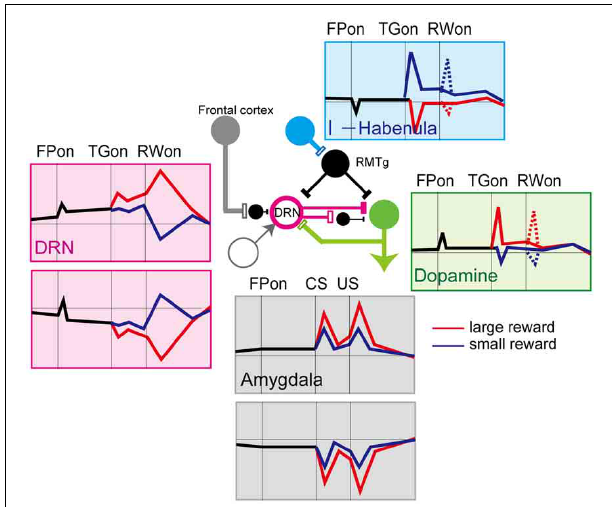
FIGURE 5 | Schematics of the activity of neurons in the different brain regions that project to the DRN. Red lines, large reward, blue lines, small reward. Activity for the biased-reward saccade task in dopamine (Kawagoe et al., 2004), lateral habenula (Matsumoto and Hikosaka, 2007, 2009), and DRN neurons (Nakamura et al., 2008), and for the Pavlovian conditioning task in the amygdala (Belova et al., 2007, 2008) is